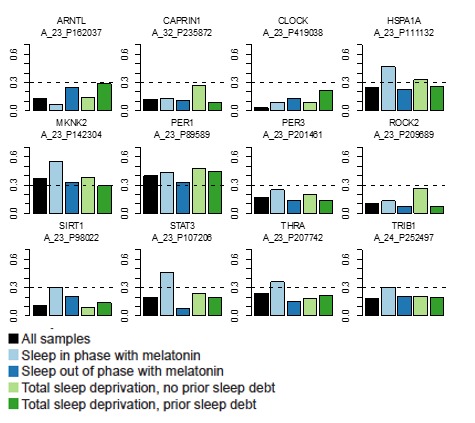
DOI:
http://dx.doi.org/10.7554/eLife.20214.025